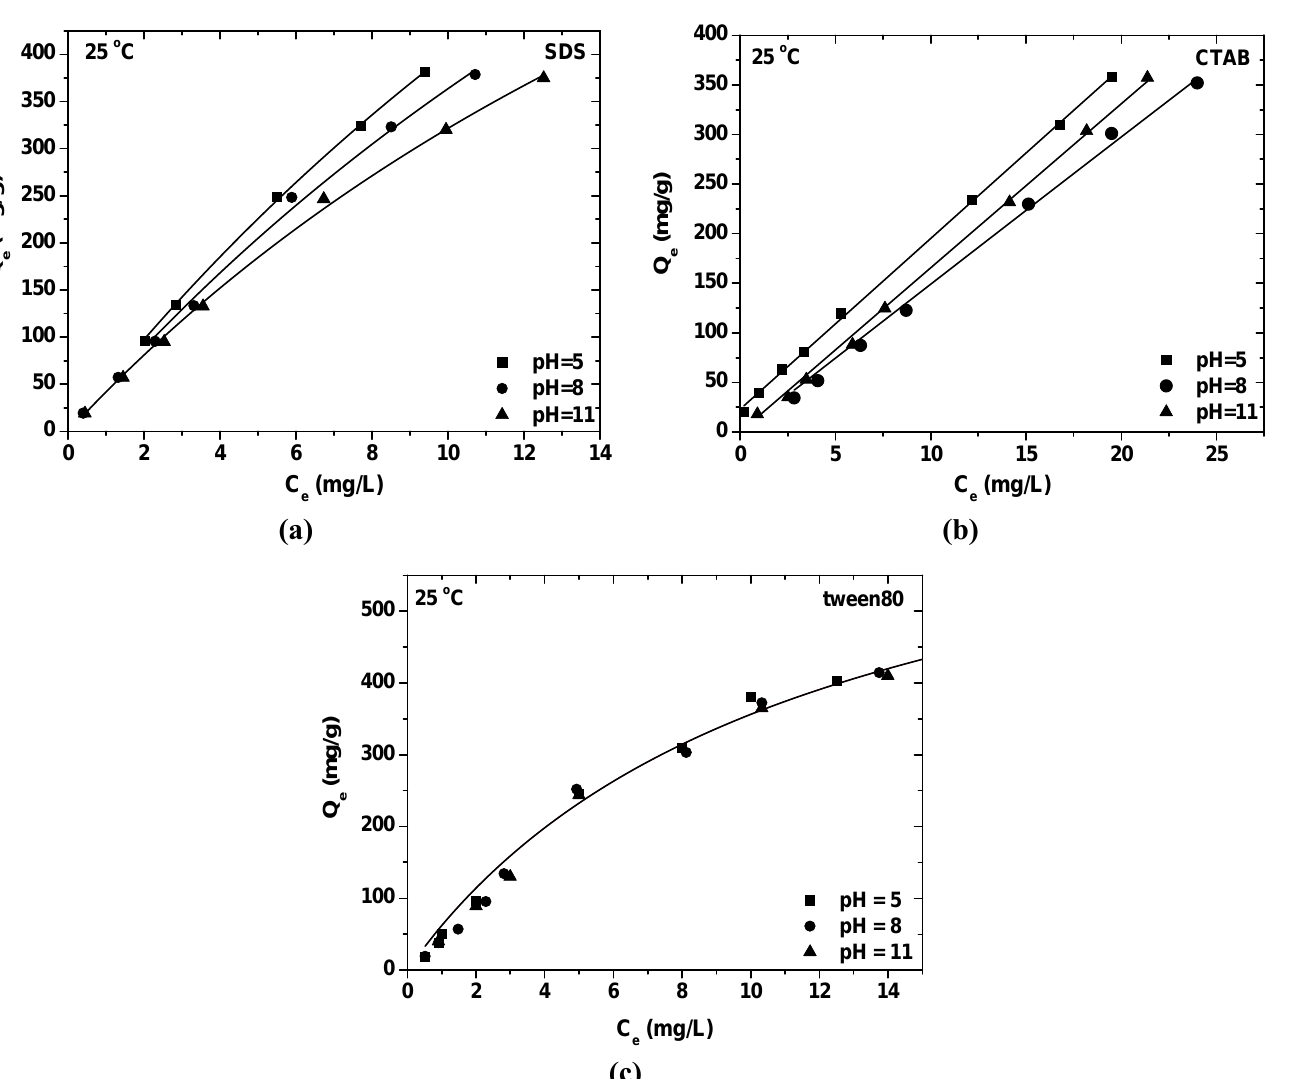
Table 4. Comparison of Q